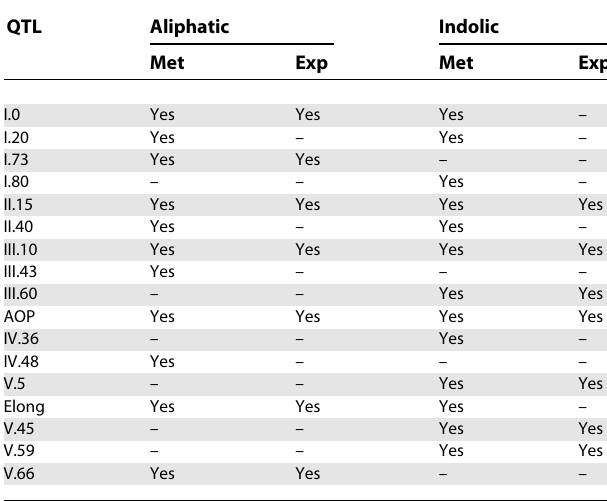
Table 2. Shared and Unique QTLs